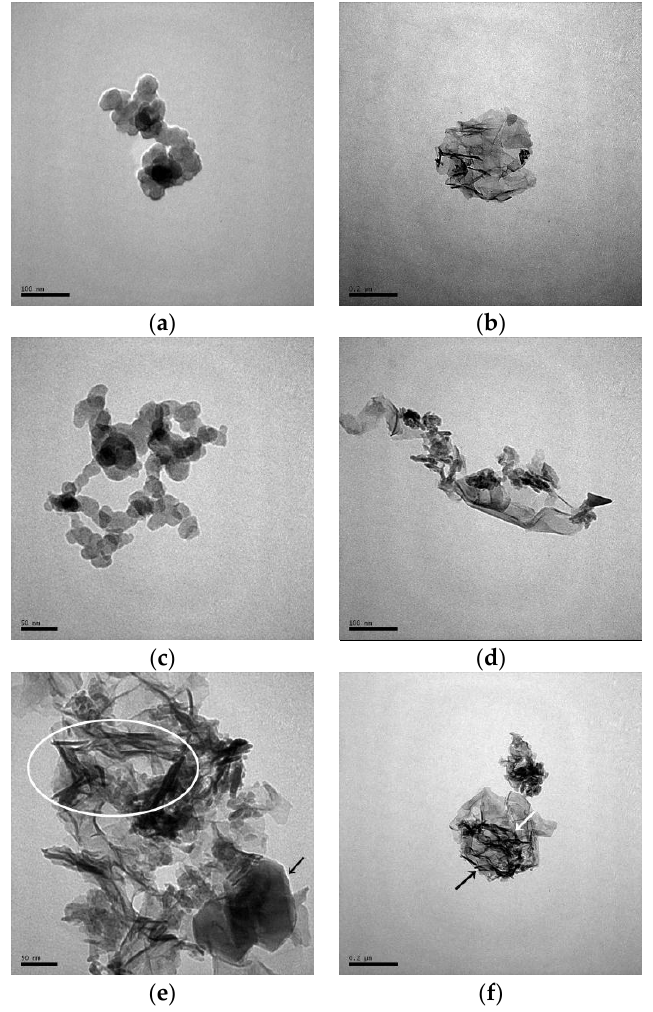
Figure 11. TEM images of the C-A-S-H system products. ( a , b ) CASH1.0_R_7d; ( c , d ) CASH1.0_60_7d; ( e , f ) CASH1.0_95_7d.